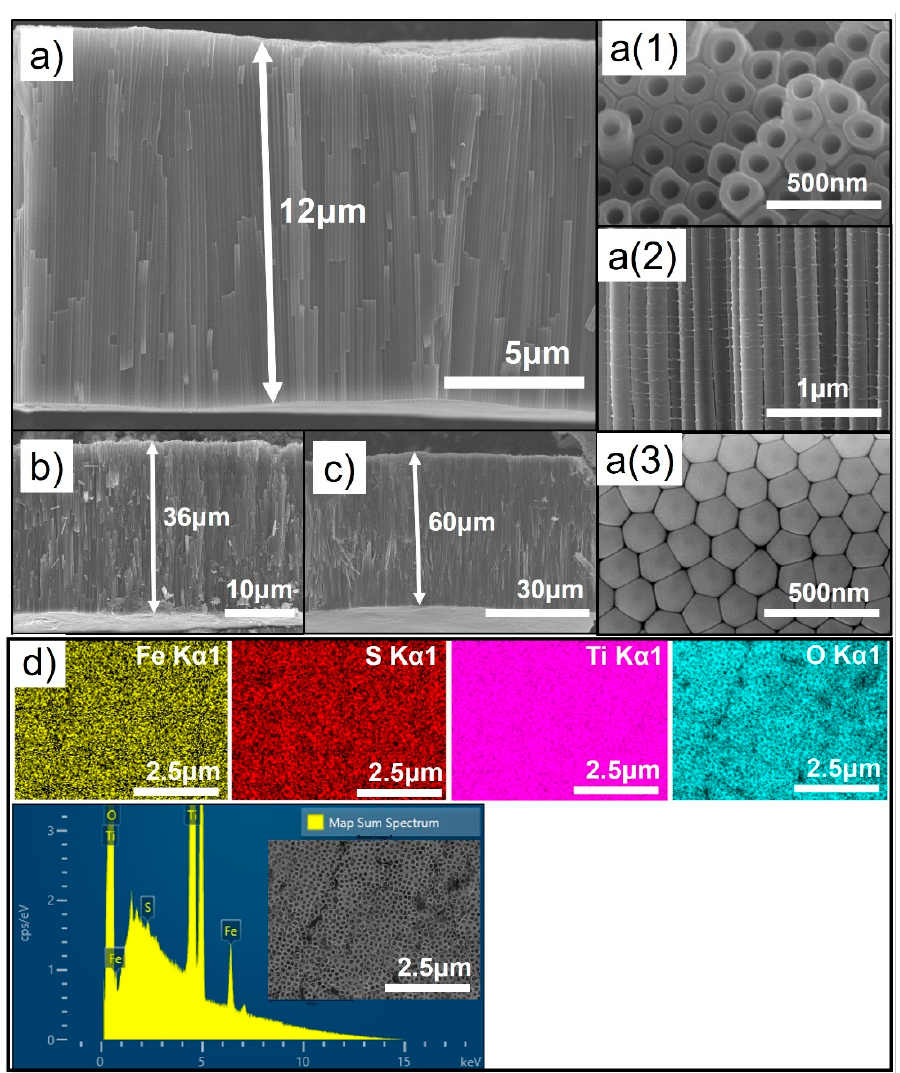
clearly shows the even distribution of elements.